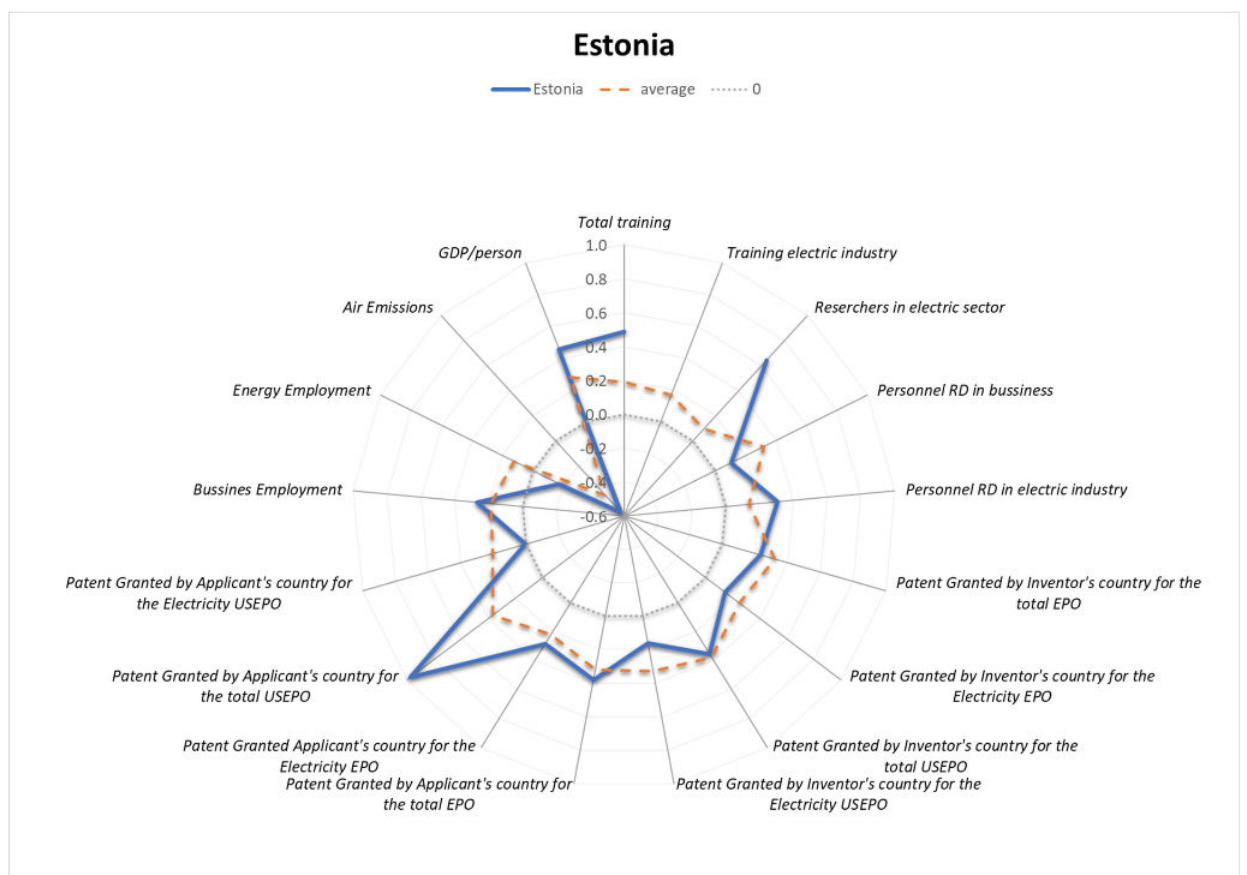
Figure 15. Synergy and trade-off occurrence—EE. Source: Authors’